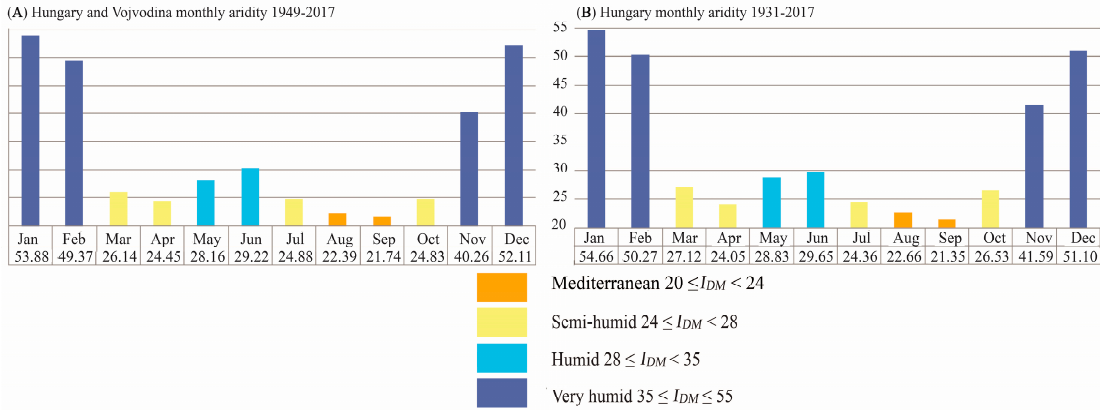
Figure 5. The monthly distribution of the mean monthly De Martonne Aridity Index for: ( A ) Hungary and Vojvodina jointly duringthe period 1949 – 2017 and for( B ) Hungary during the period 1931 – 2017.